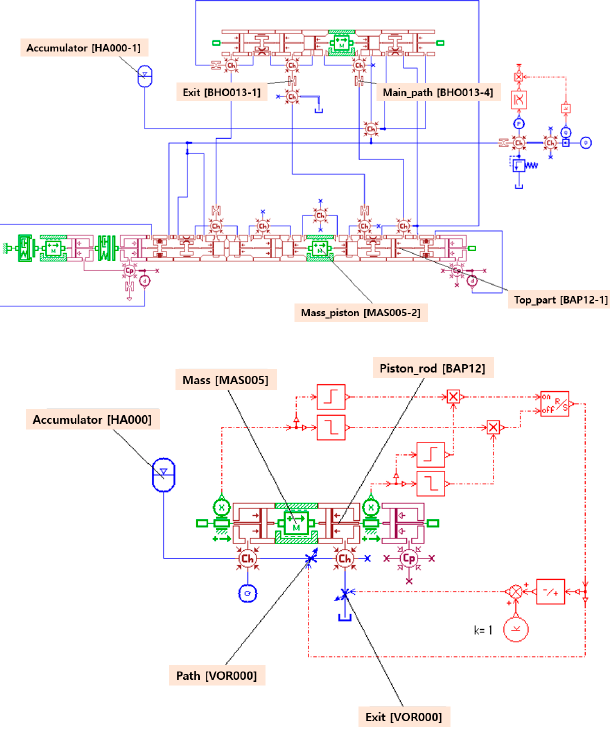
Figure 3. Breaker modeling (top: conventional/bottom: developed).